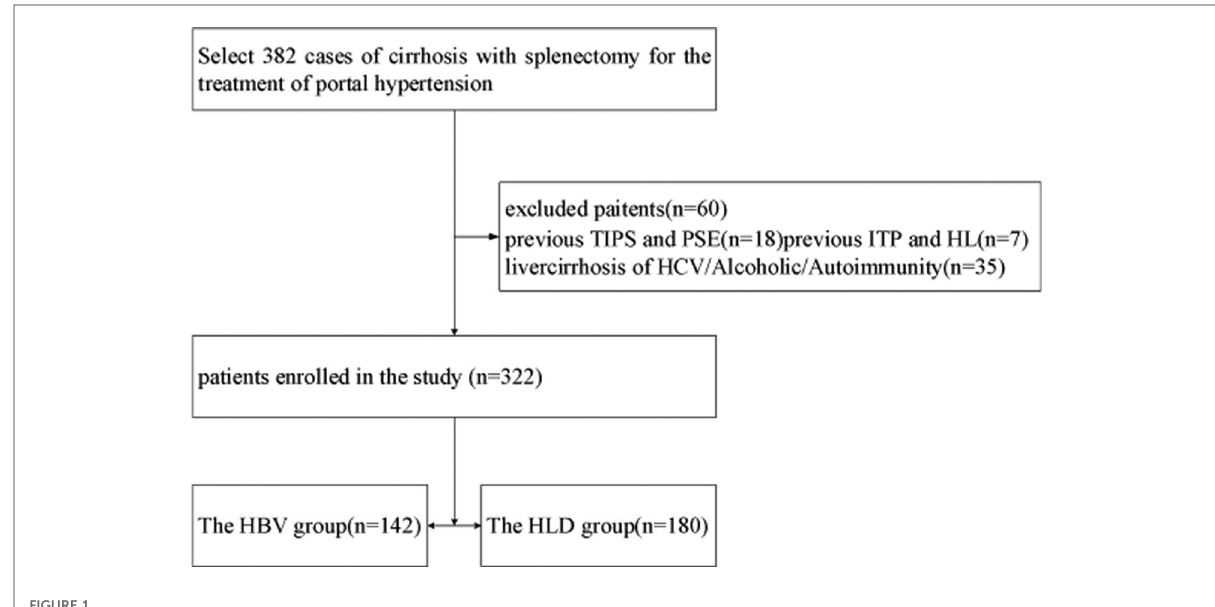
FIGURE 1 Diagram of the classi fi cation of patients who participated in this